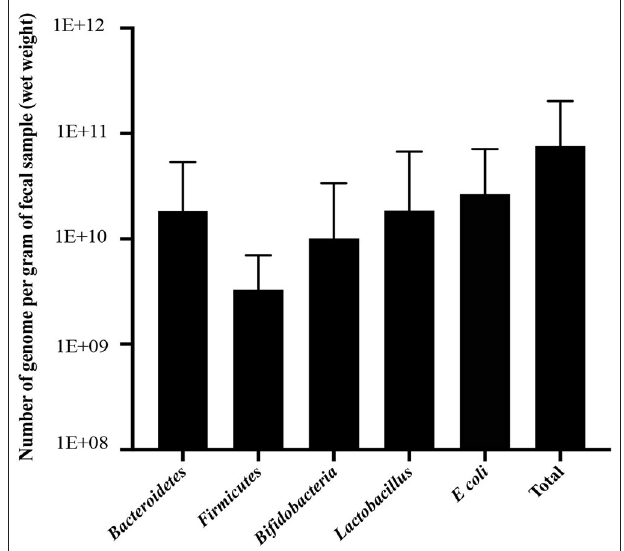
FIGURE 1 | Number of genome copies per 1g of fecal sample (wet weight) for Bacteroidetes, Firmicutes, Bifidobacteria , Lactobacillus, E. coli , and total bacteria in children with CF. Data are presented as mean and standard deviation